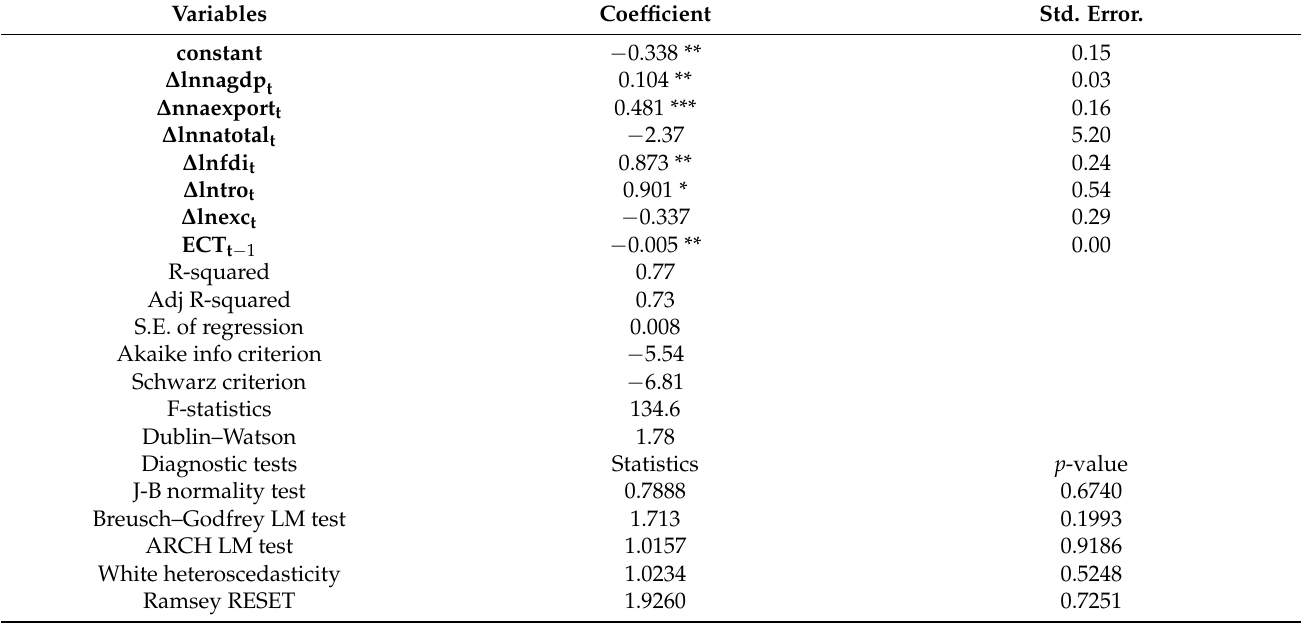
Table 7. Short-run results. Dependent variable—economic welfare.